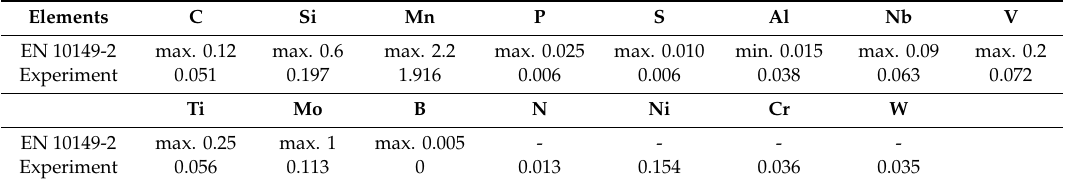
Table 1. Chemical composition (wt%) of the S700MC